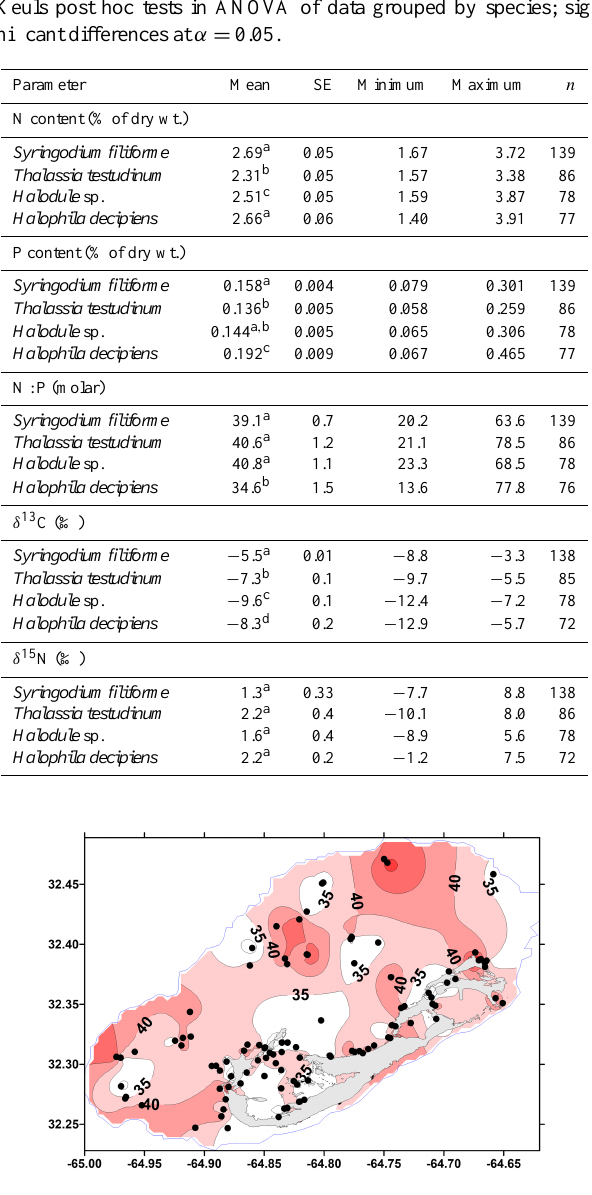
Figure 4. Isopleths of the N:P of leaves of the seagrasses Sy- ringodium filiforme and Halodule sp. Black dots indicate sampling